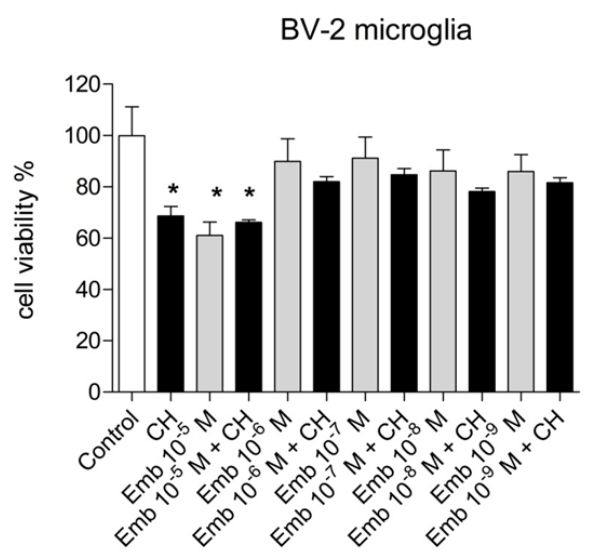
Figure 19. Cytotoxicity/proliferation (the MTT) assay carried out with embelin in the range 10 -6 – 10 -9 M in BV-2 murine microglia. The concentration of cumene hydroperoxide (CH) was 200 µM throughout the experiments. Results are the mean ± SD of two different experiments carried out in quintuplicate. *p < 0.01 at least vs. Control and embelin (10 -6 – 10 -9 M) either alone or with CH.